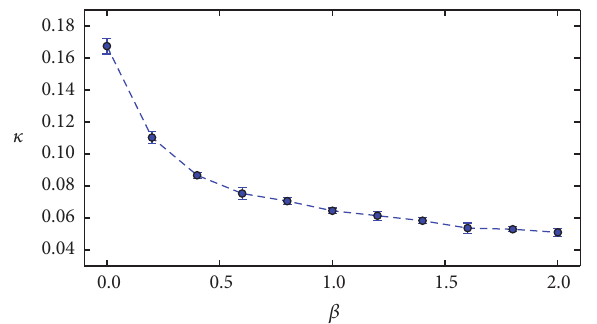
Figure 7: Scaling parameters 𝑎 and 𝑏 of the modified GJOR scheme as functions of V at 𝜖 steps of 1/5 . Each trajectory (represented by a dashed curve) refers to a different value of 𝛽 . Those with darker markers correspond to smaller values of 𝛽 and the other way round.